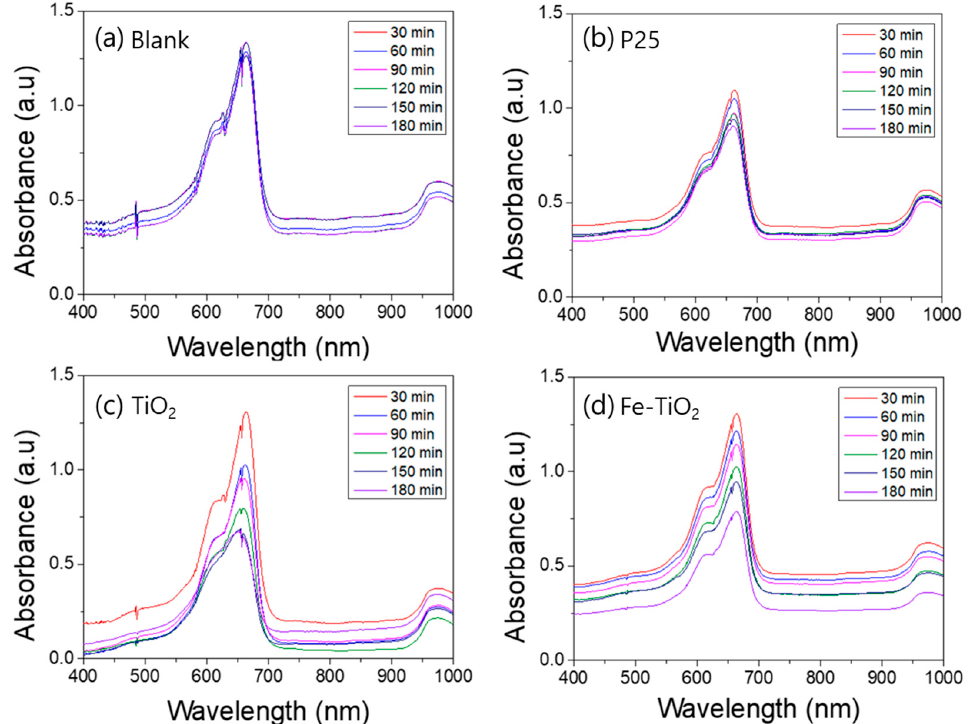
Figure 8. UV–Vis absorption spectra of the ultraviolet photocatalytic degradation of an aqueous methylene blue solution by nanofibers: ( a ) blank, ( b ) P25, ( c ) TiO 2 nanofibers, ( d ) Fe-doped TiO 2 nanofibers.